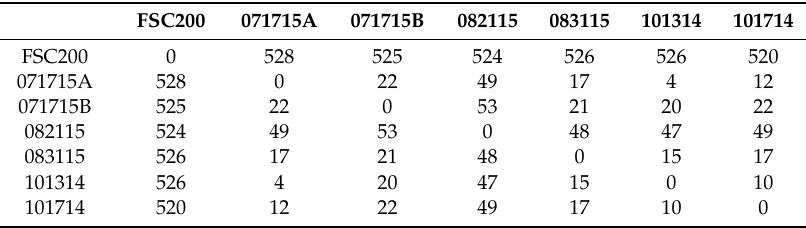
Table 1. Whole genome sequencing (WGS) single nucleotide polymorphism (SNP) pairwise matrix for the six F. tularensis type B strains isolated from the same region in the United States within a one-year period relative to each other and to the prototype type B strain FSC200 1,2 .